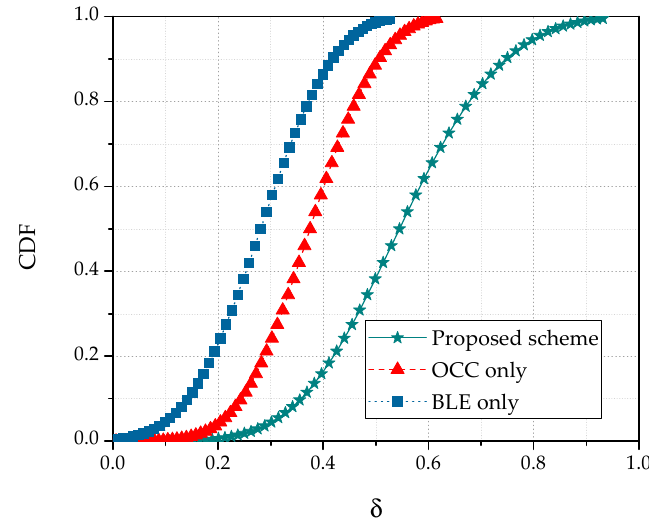
Figure 10. Cumulative distribution function of user quality of service (QoS) in the OCC, BLE, and hybrid schemes.